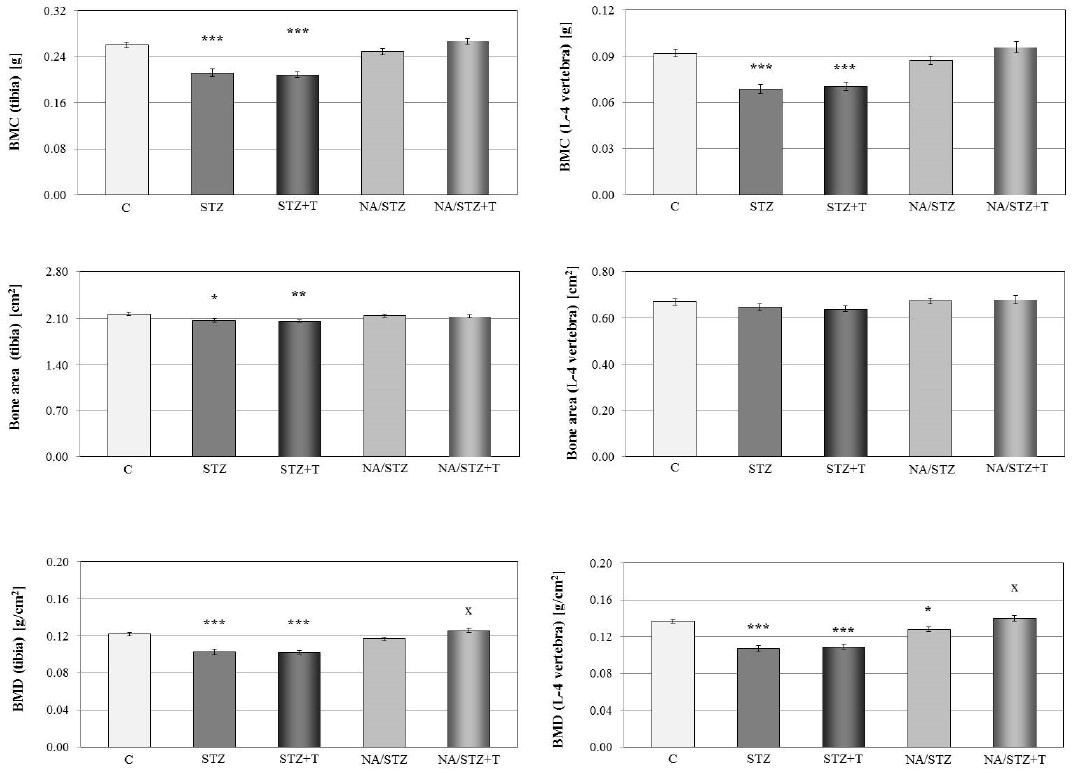
Figure 1. Effect of trigonelline (T; 50 mg/kg p.o. for four weeks) on BMC, bone area and BMD of the tibia (without the proximal epiphysis) and L-4 vertebra in rats treated with streptozotocin (STZ) or nicotinamide and streptozotocin (NA/STZ). Results are presented as means ± SEM ( n = 7–10). Kruskal–Wallis ANOVA followed by Mann–Whitney U test were used for evaluation of the significance of the results. * p < 0.05, ** p < 0.01, *** p < 0.001—significantly different from the control group (C), x p < 0.05—significantly different from the NA/STZ group. Table 2. Effect of trigonelline (50 mg/kg p.o. for four weeks) on the composition of the femur, tibia, and L-4 vertebra in rats treated with streptozotocin (STZ) or nicotinamide and streptozotocin (NA/STZ).